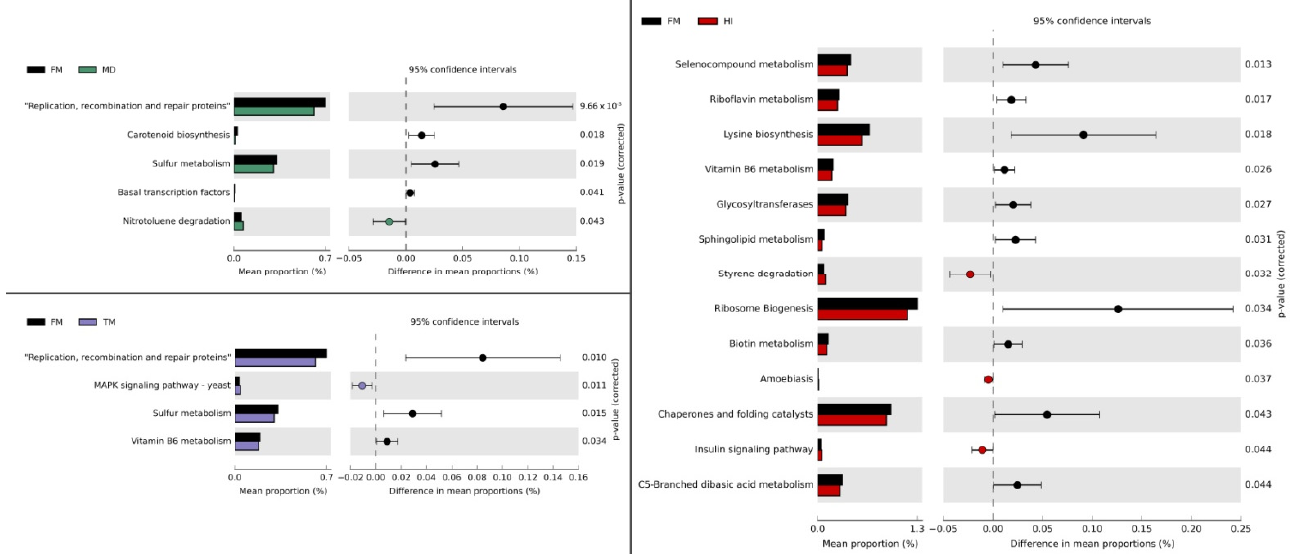
Figure 6. Significantly altered bacterial Kyoto Encyclopedia of Genes and Genomes (KEGG) pathways at level 3 (Welch’s t -test, p < 0.05) between fish meal (FM) and insect meal (HI, TM, MD) diets fed to Sparus aurata . Predicted functional pathways based on differential abundance were generated by PICRUSt and STAMP analyses. Significant differences were calculated using the Welch’s inverted confidence interval method. Abbreviations according to Figure 1.